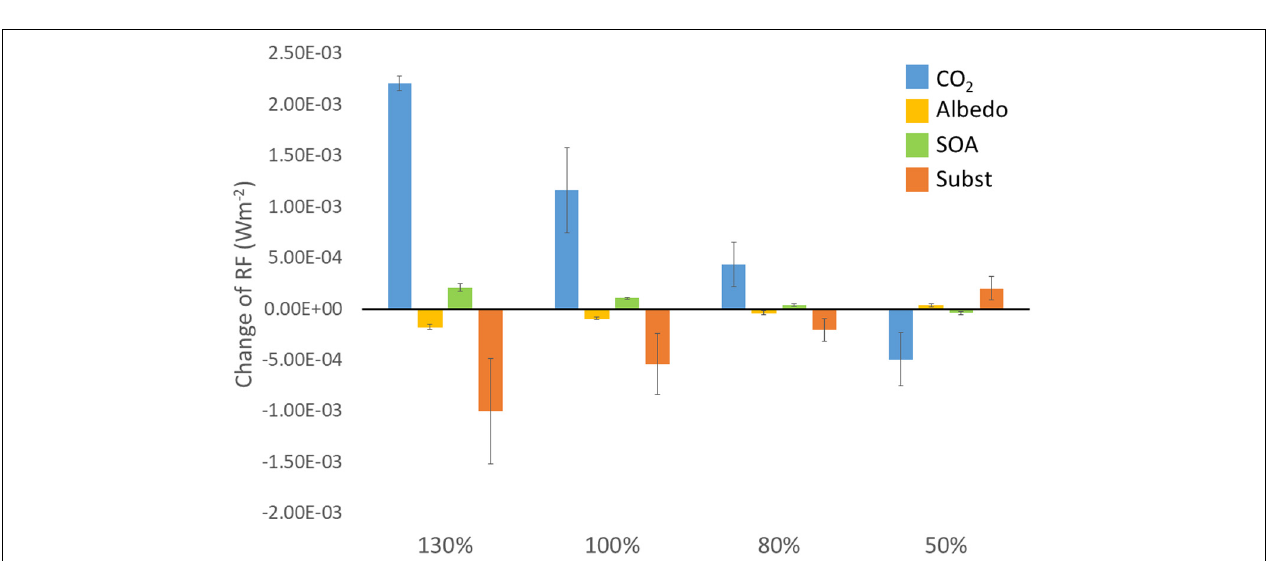
FIGURE 4 | The annual difference of the global radiative forcing (RF) between each scenario and the baseline (65% of CAI), in the current climate (cf. Eq. 3) (A) excluding avoided emissions from substitution and (B) including avoided emissions (the total impact). Different colors represent varying harvest levels given as a percentage of present CAI in Finland and the shaded area represents the estimated min-max range (see text).